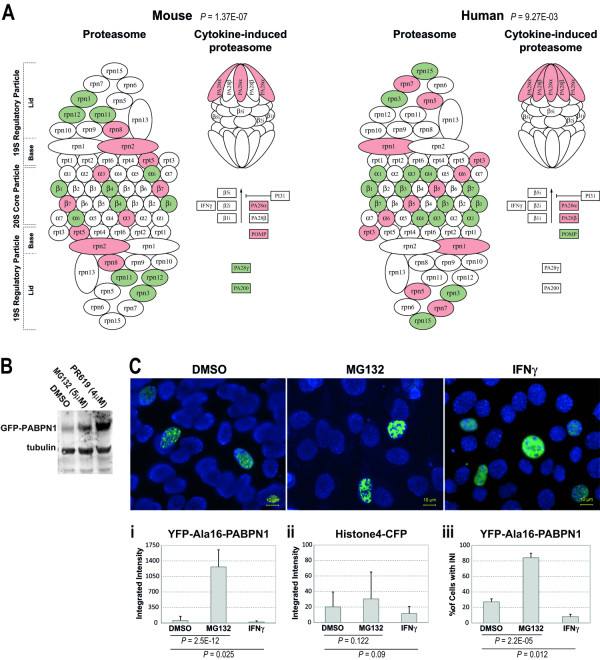
The effect of altered proteasome activity on expPABPN1 accumulation and aggregation. A) Substantial deregulation of proteasome and immunoproteasome encoding genes in mice and humans. Down-regulation (green) is more pronounced in the core subunit of the proteasome. Immunoproteasome shows consistent up-regulation (red) in both organisms. B) Western blot analysis of YFP-Ala16-PABPN1 transfected C2C12 cells that were treated with 5 μM MG132 or 5 nM PR619. Control cells were treated with DMSO. C) Images show YFP-Ala16-PABPN1 localization in C2C12 after mock-treatment (DMSO), 5 μM MG132 or 5 U/ml IFNγ. Scale bar equals 10 μm. Histograms show the integrated intensity of YFP-Ala16-PABPN1 (i) or Histone4-CFP (control) (ii), and the percentage of cells with INI in YFP-Ala16-PABPN1 expressing cells (iii). Averages represent 509, 773 and 476 cells for DMSO, MG132 and IFNγ, respectively. Significant difference between treatments is reflected by P-values.